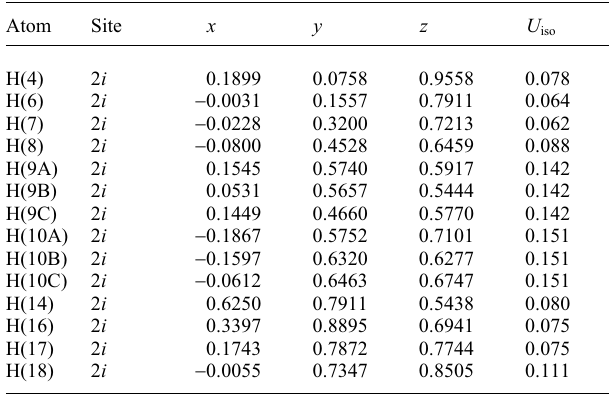
Table 2. Atomic coordinates and displacement parameters (in Å 2 )